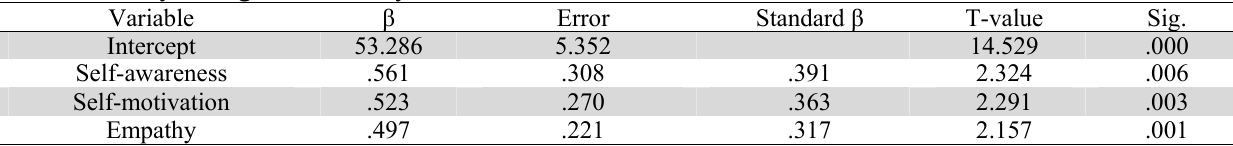
The summary of regression